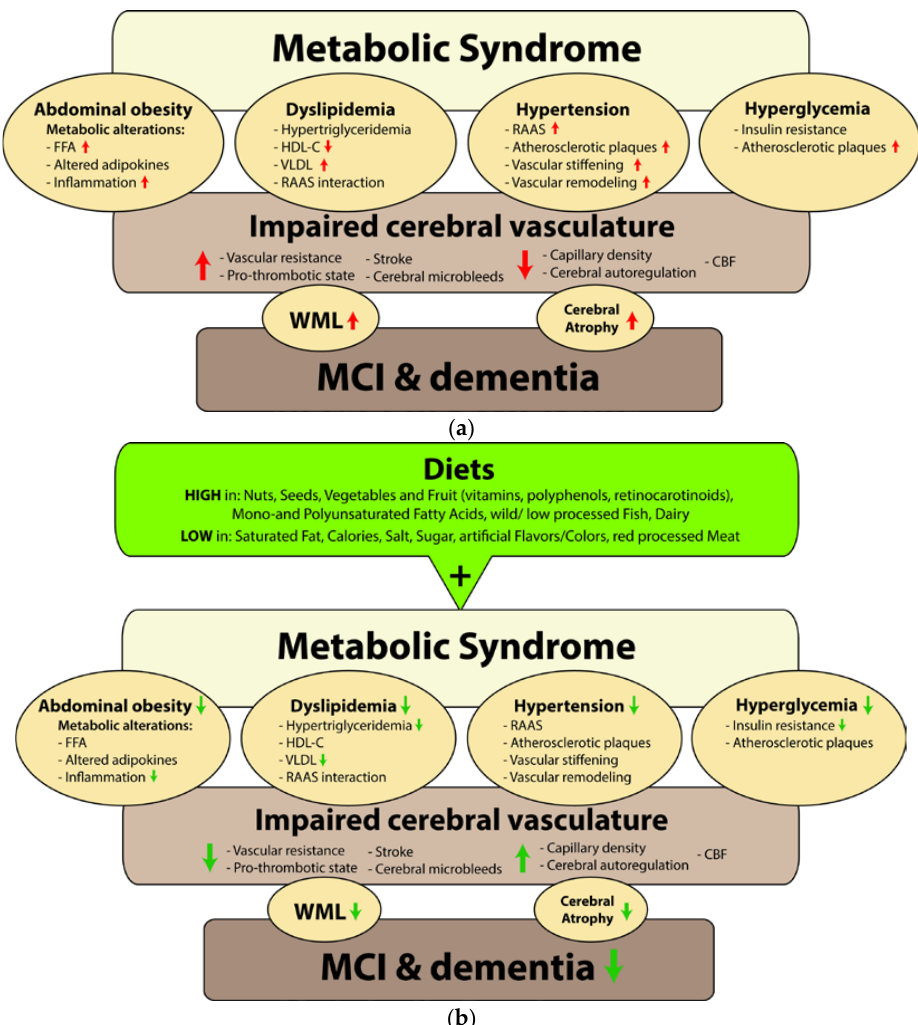
Figure 1. ( a ) The four components abdominal obesity, dyslipidemia, hypertension, and hyperglycemia comprising Metabolic Syndrome (MetS), contribute all to structural and functional alterations in the peripheral and brain vasculature. Associated factors highly contributing to the development of MetS are inappropriate diets physical inactivity, advancing age, and various hormones (not depicted here). Abdominal obesity is associated with metabolic alterations, including elevated FFA’s and an altered production of proinflammatory and anti-inflammatory adipokines resulting in a pro-inflammatory status. Atherogenic dyslipidemia involves hypertriglyceridemia, decreased levels of HDL-C, increased VLDL and interaction with RAAS. Increased RAAS activity is one of the mechanisms causing elevated blood pressure levels. Hypertension contributes to the atherosclerotic process and increased vascular stiffening and remodeling. Hyperglycemia is often proceeded and accompanied by IR and both influence the atherosclerotic process. Several associations and interactions are found within these processes and are also related to IR and T2DM. Alterations in the vasculature might lead to an increased vascular resistance, pro-thrombotic status, stroke, and microbleeds, while reductions are found in capillary density, cerebral autoregulation, and CBF. These features can accelerate the development of WML and cerebral atrophy, which eventually increase the risk of developing MCI and dementia. FFA = free fatty acids, HDL-C = high density lipoprotein cholesterol, VLDL = very-low-density lipoprotein, RAAS = renin-angiotensin-aldosterone-system, IR = insulin resistance, T2DM = type 2 diabetes mellitus, CBF = cerebral blood flow, WML = white matter lesions, MCI = mild cognitive impairment; ( b ) Scheme of the potential influence of dietary components on MetS and related impairment of cerebral vasculature and cognition [148,149,151,189]. 13